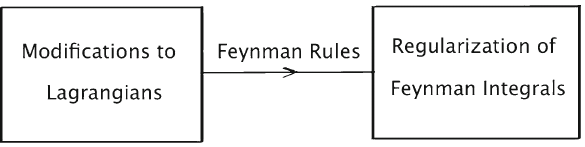
Fig. 1 Mediation scenario for the regularization of Feynman integrals